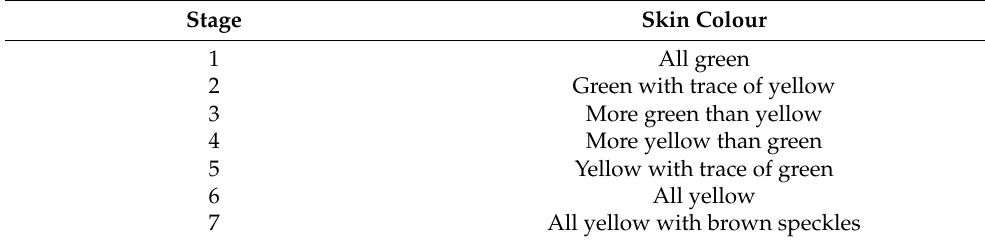
Table 1. Maturity stage of bananas.